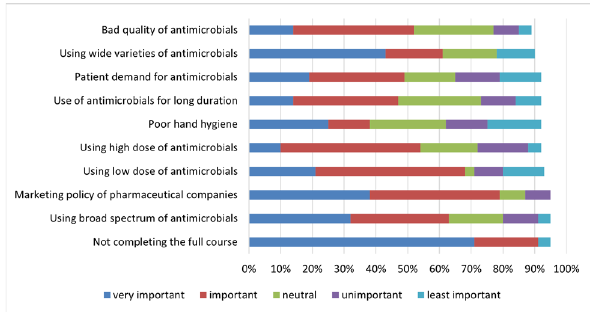
Figure 2: Perception of veterinarians to the most and least important causes of antimicrobial resistance